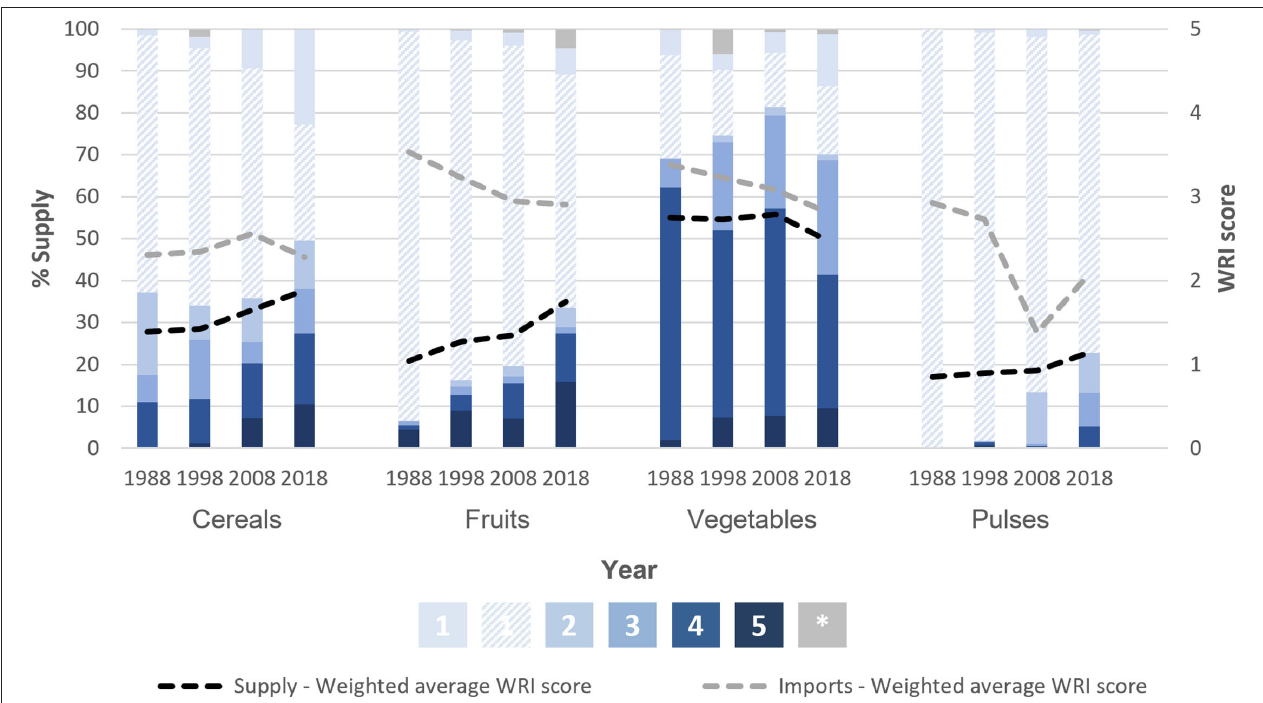
FIGURE 4 | Projected water stress (WRI score) of country of origin of cereals, fruits, vegetables and pulses supplied to The Gambia. The proportion of supply, within a given crop group and for a given year (1988, 1998, 2008 or 2018), originating in countries of varying projected 2040 water stress levels (ratio of total water withdrawals to total renewable supply, WRI Aquaduct). There are five levels of water stress: [1] Low ( < 10%); [2] Low to medium (10–20%); [3] Medium to high (20–40%); [4] High (40–80%); [5] Extreme ( > 80%); plus those that are unknown [*-gray]. Projected water stress increases as colors move from light to dark blue. Domestic production is shown with diagonal stripes and falls into the low stress [1] category. This figure also shows the weighted average WRI score of total supply (black dashed line) and of imports (gray dashed line). All data are 3-year rolling averages. Analysis of 2040 projections based on a business-as-usual scenario. All data between the years of 1988 and 2018 were analyzed, but we present 1988, 1998, 2008, and 2019 as evenly spaced time intervals for figure readability. Data for all years can be found in the supplementary materials ( Supplementary Figure 5